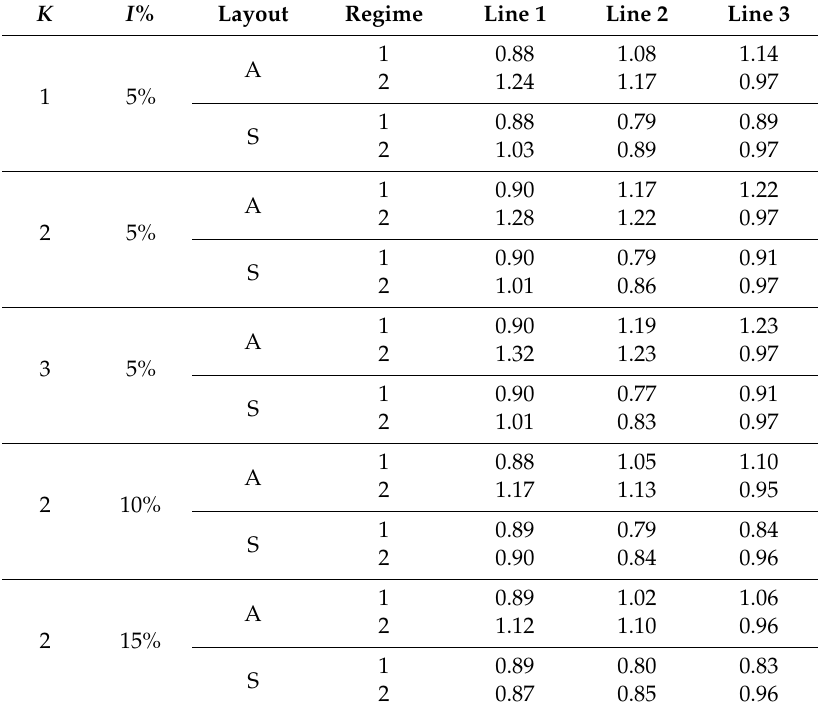
Figure 10. Time evolution of the mean power per line with and without current incidence: ( a ) P1 m (MW) for an aligned layout (S); ( b ) P2 m (MW) for an aligned layout (S); ( c ) P3 m (MW) for an aligned layout (S). Table 4. Ratio between P im (RWI) and P im (RWOI) for K = 2 and I = 5% configurations. The results are averaged per